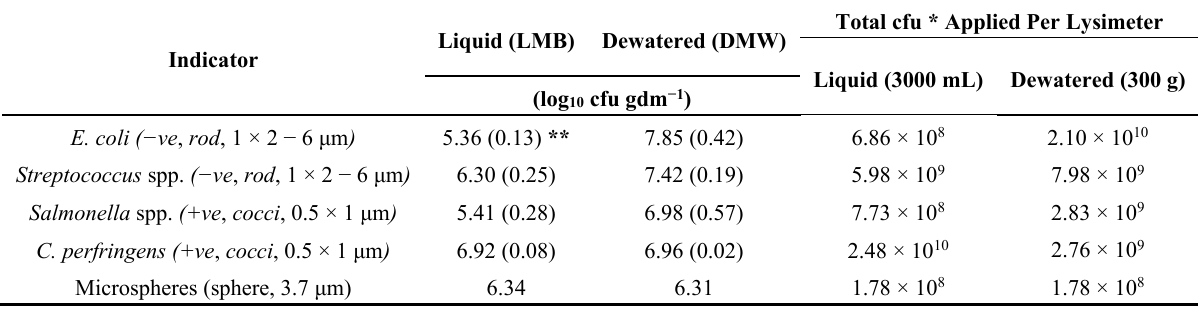
Table 2. Concentration of bacteria and fluorescent hydrophobic microspheres in the test biosolids.